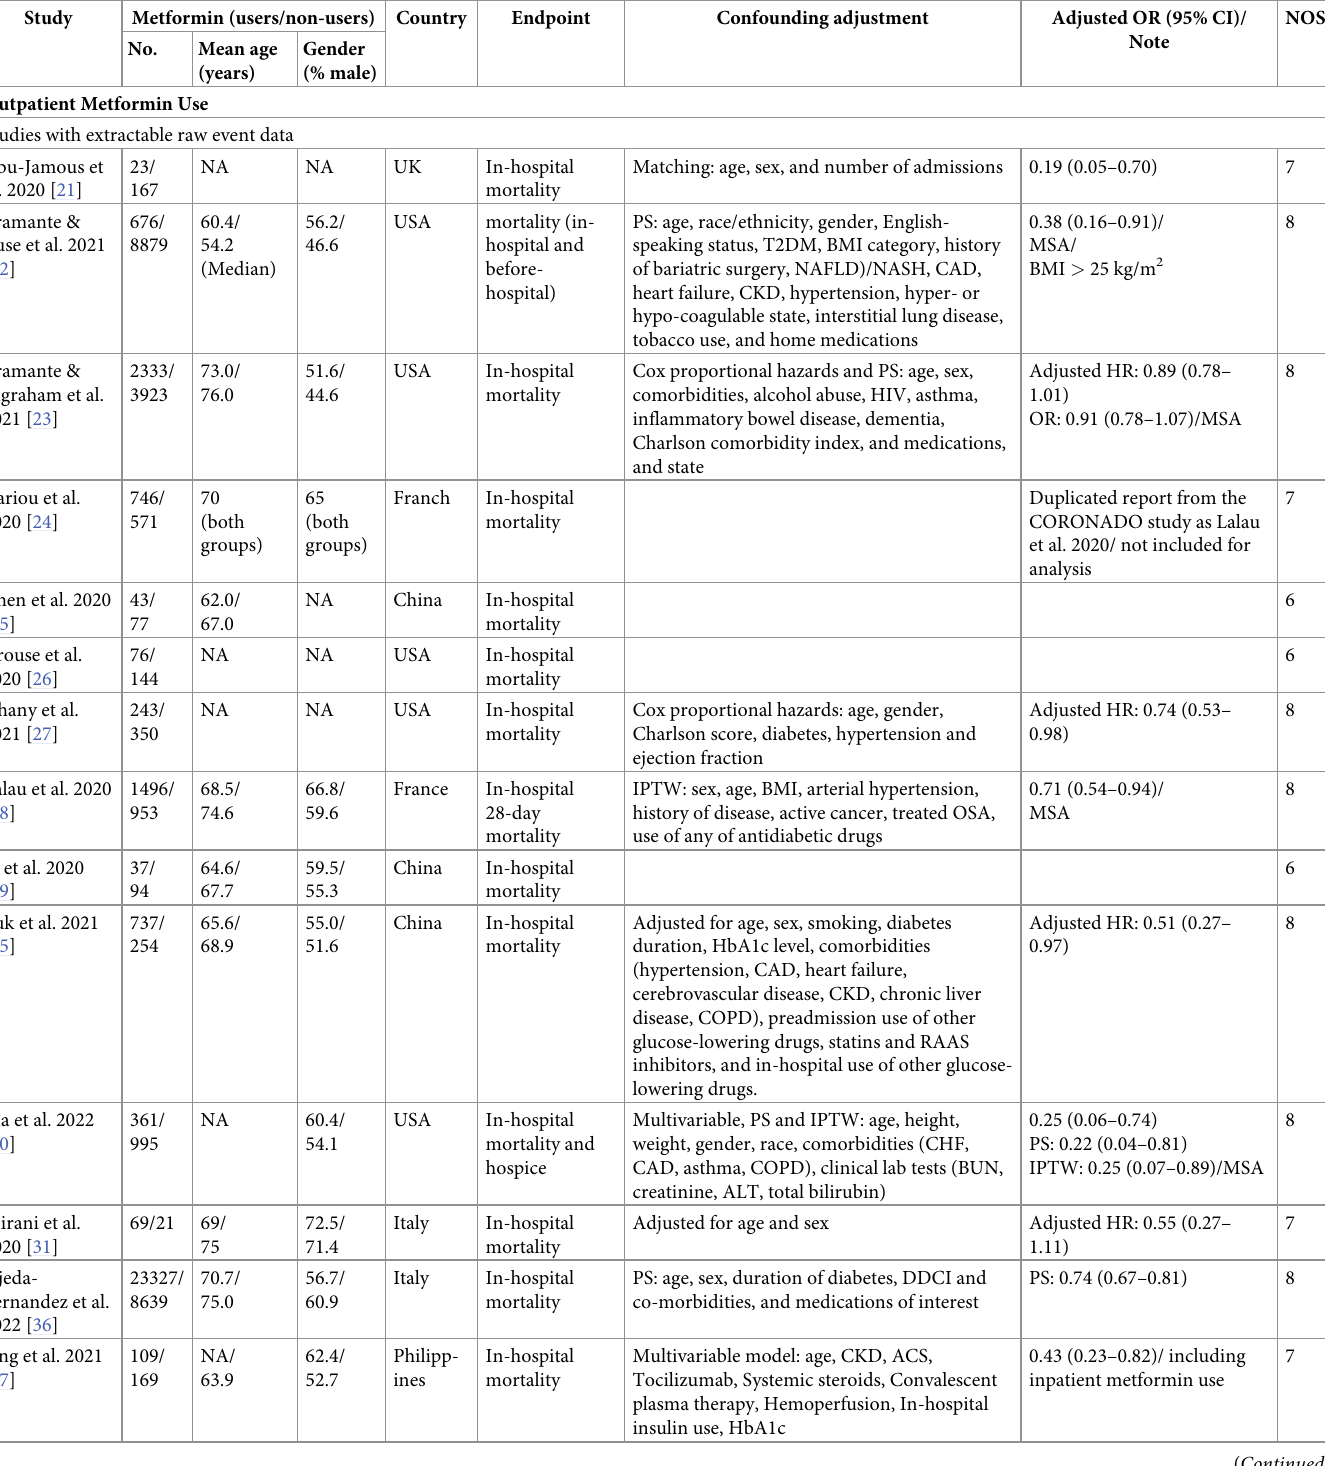
Table 1. Characteristics of studies comparing mortality in metformin users vs non-users in patients with type 2 diabetes hospitalized for